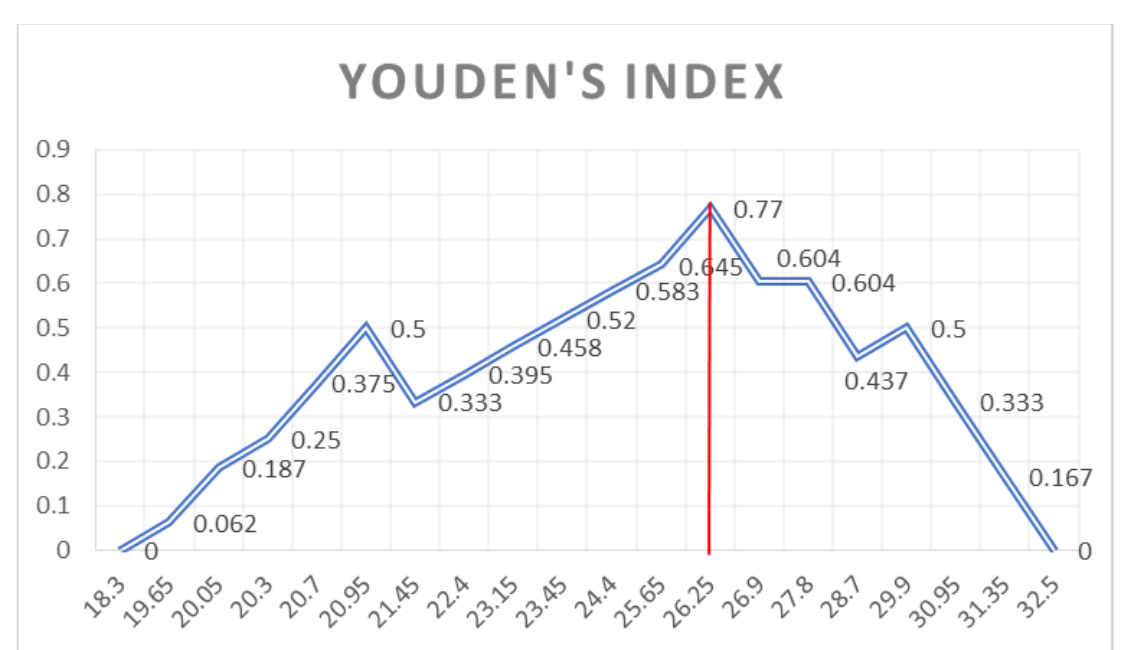
Figure 5. Youden’s index of the AML length ROC curve.